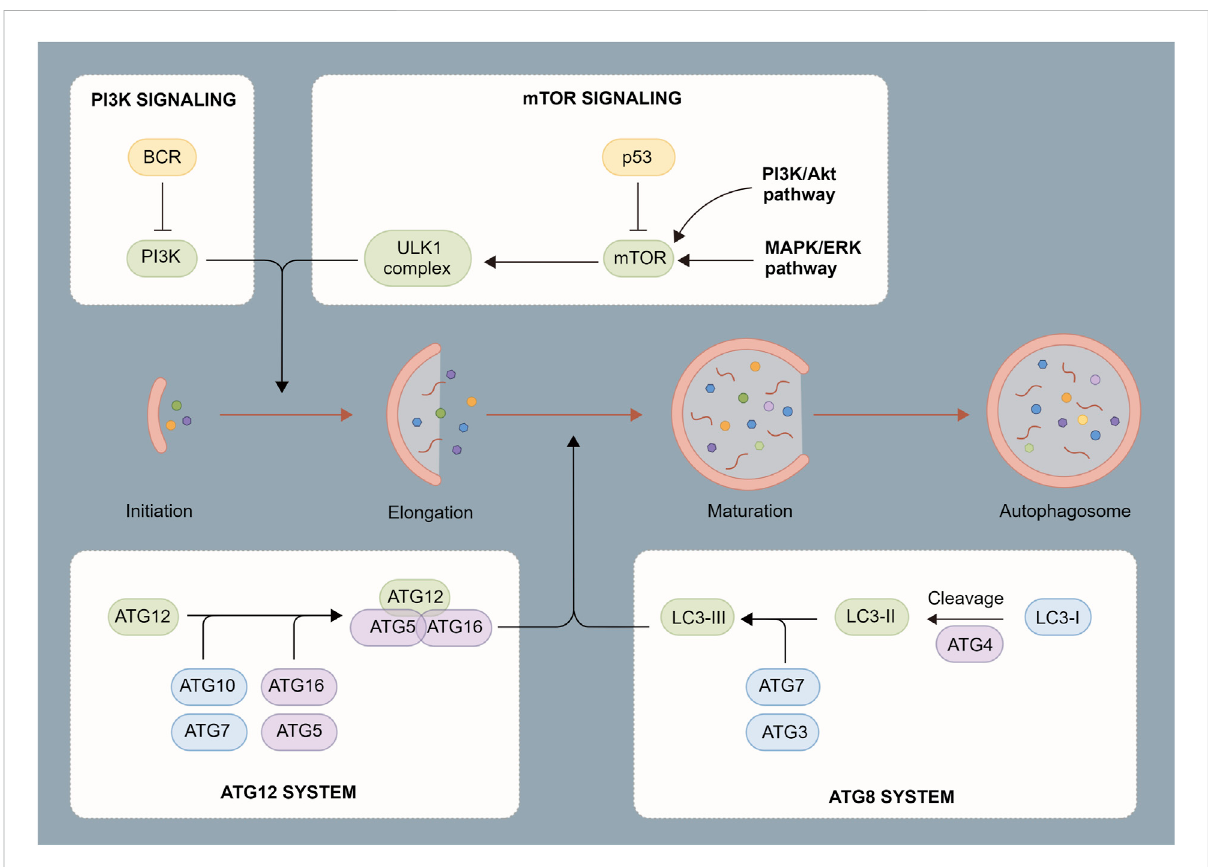
FIGURE 2 Processofautophagosomeformation.Autophagosomesarecomposedofadoublemembraneenclosingasmallportionofthecytoplasm.The cytoplasm contains digested material consisting of various components such as mitochondria, endoplasmic reticulum fragments, etc. The contents are degraded through fusion with